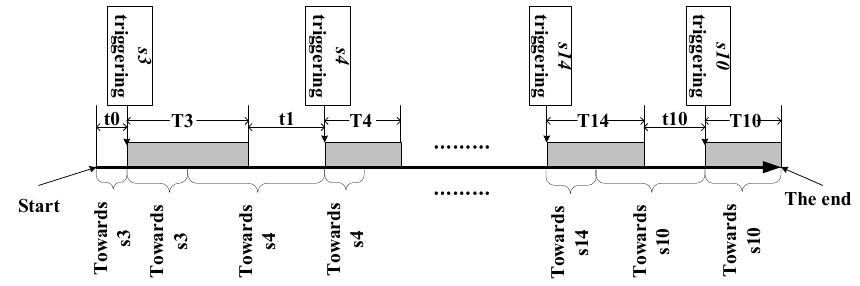
Figure 11. State transition for the route1.